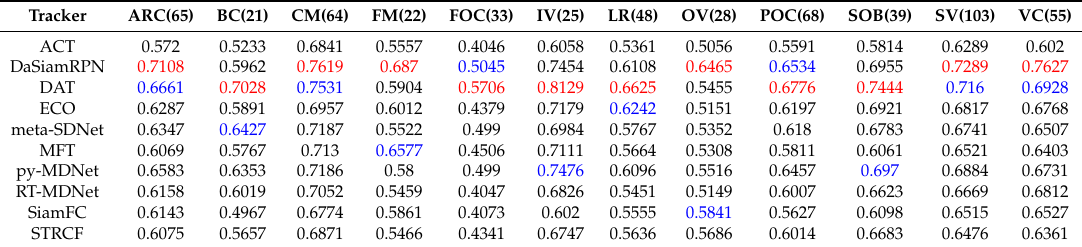
Table 5. Precision results for various UAV123 dataset attributes listed in Table 1. Top performing tracker is shown in red and the second best performer is shown in blue. Best viewed in color. Tracker